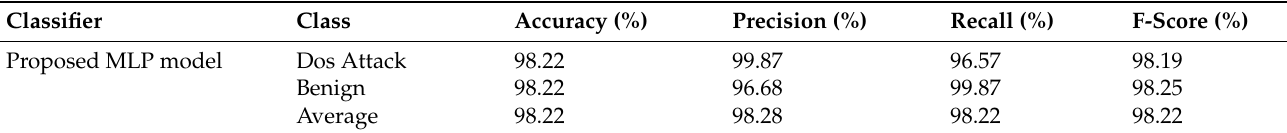
Table 7. Results of MLPNN